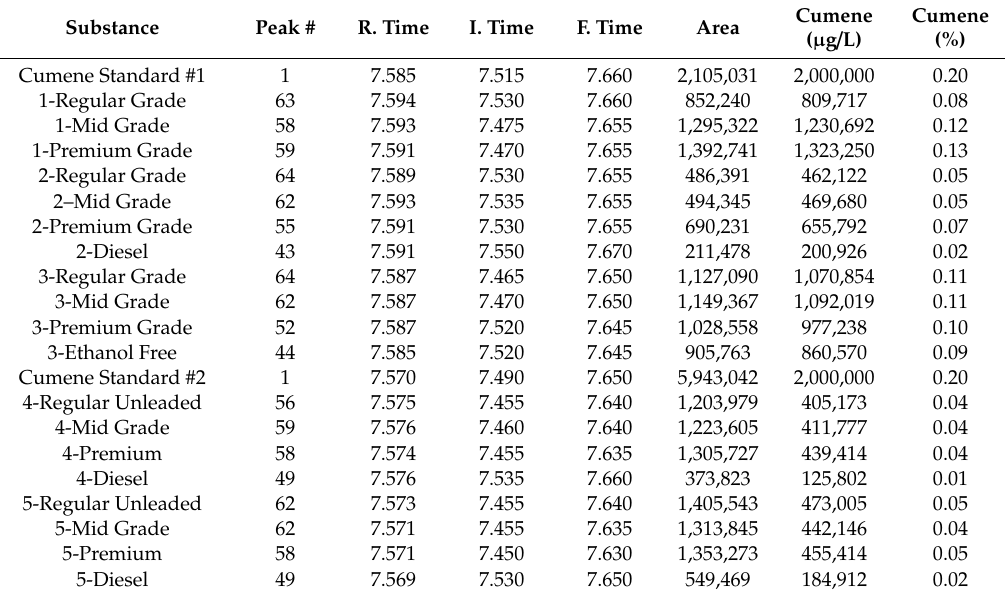
Table 4. Cumene concentration in various modern